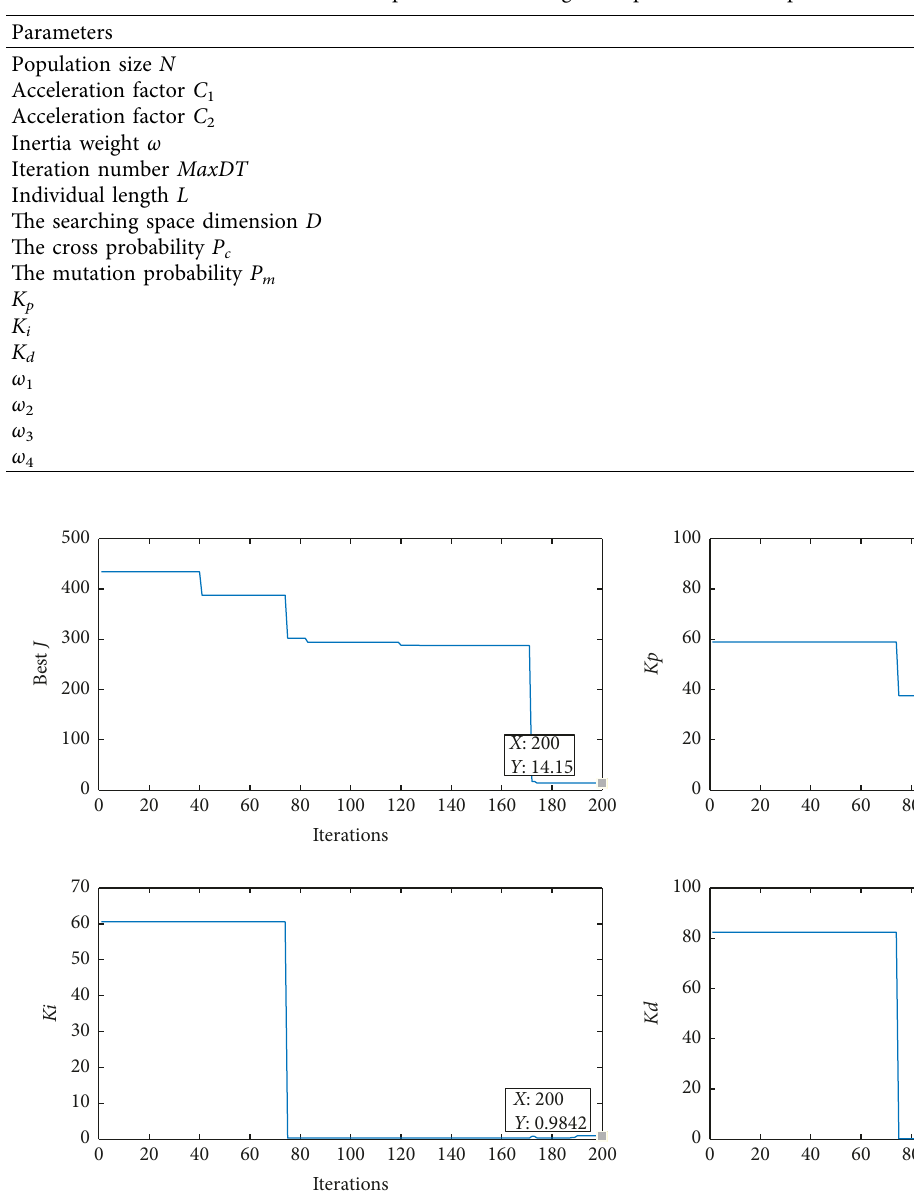
Table 1: The parameters of the genetic particle swarm optimization algorithm.